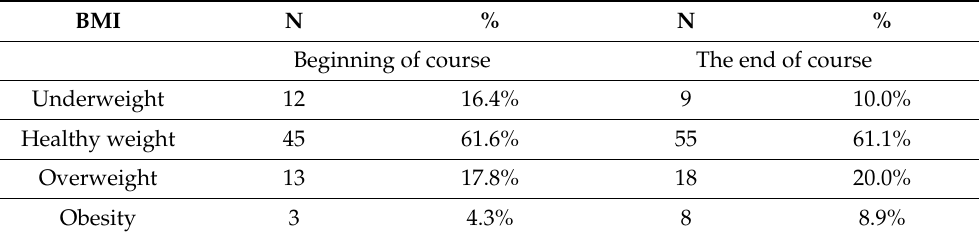
Table 4. Data of subjects as a function of body mass index